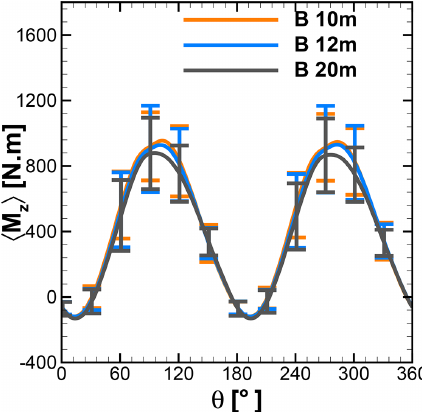
Figure 19. Moment of the complete rotor at different heights over rooftop of